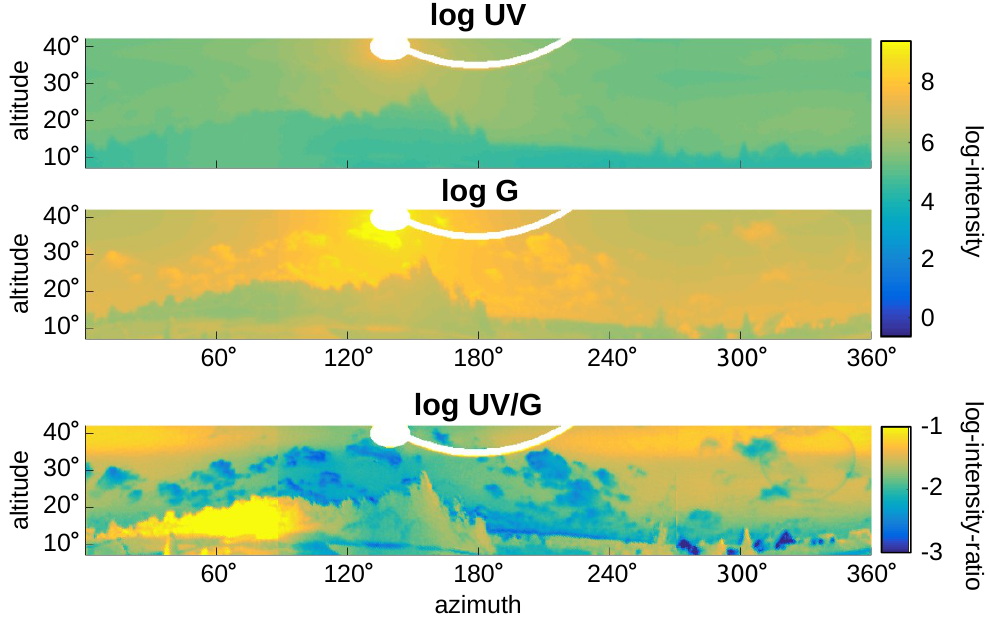
Figure 16. A panoramic image of fields and forest in front of a clouded sky has been captured at 18:30 on a sunny day in the vicinity of Bielefeld University on 27 June 2016 (for additional information, compare Figure 15). Note that while there are many clouds in the sky, the Sun itself is not covered by clouds. The performance of the best global and local separation techniques tested in this study are shown in Figure